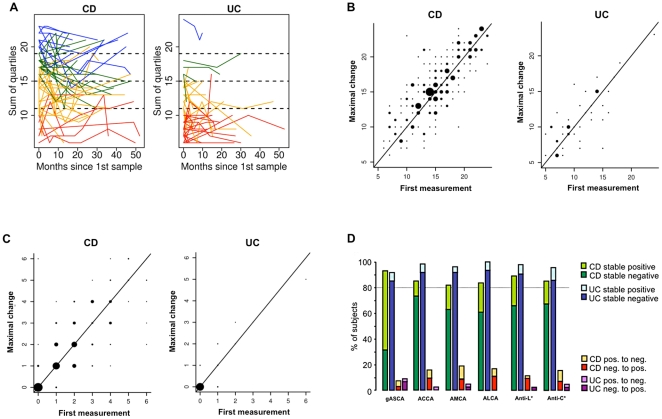
A. Changes in quartile sum score over time. Profile plots for changes in the quartile sum score (QSS) in individual Crohn's disease (CD) and Ulcerative colitis (UC) patients over time. The broken lines represent four equal sections of the QSS. The blue, green, yellow and red lines indicate patients starting in a certain section of the QSS. Depicted is a random set of 50 subjects per graph. B. Maximal changes in the quartile sum score. Scatter plots comparing the quartile sum score (QSS) of the first sample and the sample with the maximal changes in QSS during follow-up in Crohn's disease (CD) and Ulcerative colitis (UC) patients. The size of the dots represents the number of patients per datapoint. C. Maximal changes in number of positive markers. Scatter plots comparing the number of positive markers of the first sample and the sample with the maximal changes in quartile sum score during follow-up in Crohn's disease (CD) and Ulcerative colitis (UC) patients. The size of the dots represents the number of patients per datapoint. D. Stability in antibody status over time. First sample compared to sample with with the maximal changes in quartile sum score during follow-up in Crohn's disease (CD) and Ulcerative colitis (UC) patients. Values are presented as N (%) for changes in marker status. gASCA: anti-Saccharomyces cerevisiae antibodies, ACCA: anti-chitobioside carbohydrate IgA antibodies, ALCA: anti-laminaribioside carbohydrate IgG antibodies, AMCA: anti-mannobioside carbohydrate IgG antibodies, Anti-L: anti-laminarin carbohydrate antibody, Anti-C: anti-chitin carbohydrate antibody; pos.: positive, neg.: negative; *Anti-L and Anti-C were not available in all patients.